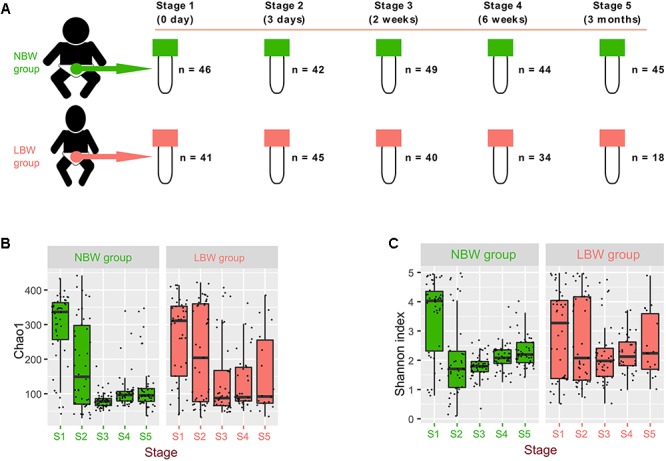
Microbiota diversity varied by birth weight and sampling time. Total 404 samples were collected from 134 infants at 0 day, 3 days, 2 weeks, 6 weeks, and 3 months after their birth (defined as different stages range from stage 1 to stage 5) (A). Alpha-diversity of gut microbiota, measured by Shannon (B) and Chao1 (C) index.